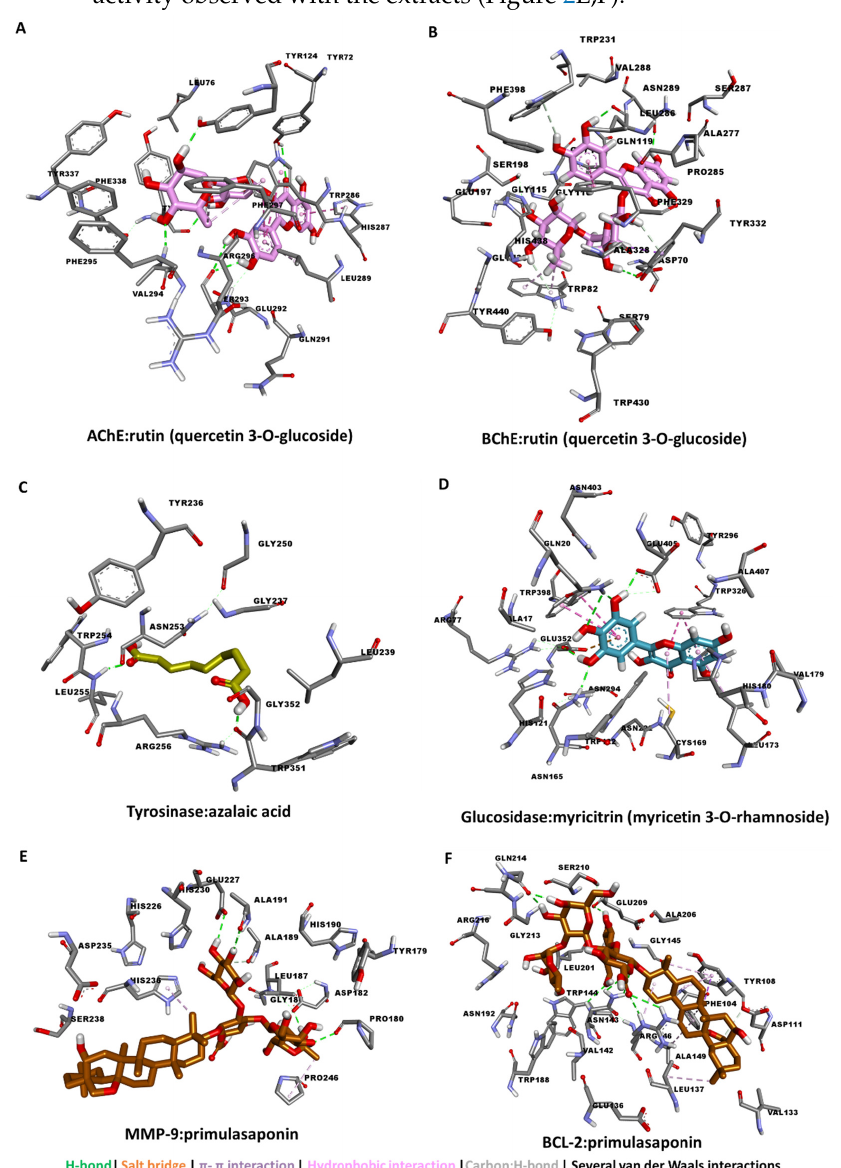
Figure 2. Protein–ligand interaction: ( A ) AChE and rutin (quercetin 3- O -glucoside), ( B ) BChE and rutin (quercetin 3- O -glucoside), ( C ) amylase and azalaic acid, ( D ) glucosidase and myricitrin (myricetin 3- O -rhamnoside), ( E ) MMP-9 and primulasaponin, and ( F ) BCL-2 and primulasaponin. Taken together, the major compounds in the extracts of P. auriculata are likely exert- ing biological activity by binding to the catalytic channels of AChE, BChE, tyrosinase, am- ylase, and glucosidase as well as the cancer target proteins MMP-9 and BCL-2.